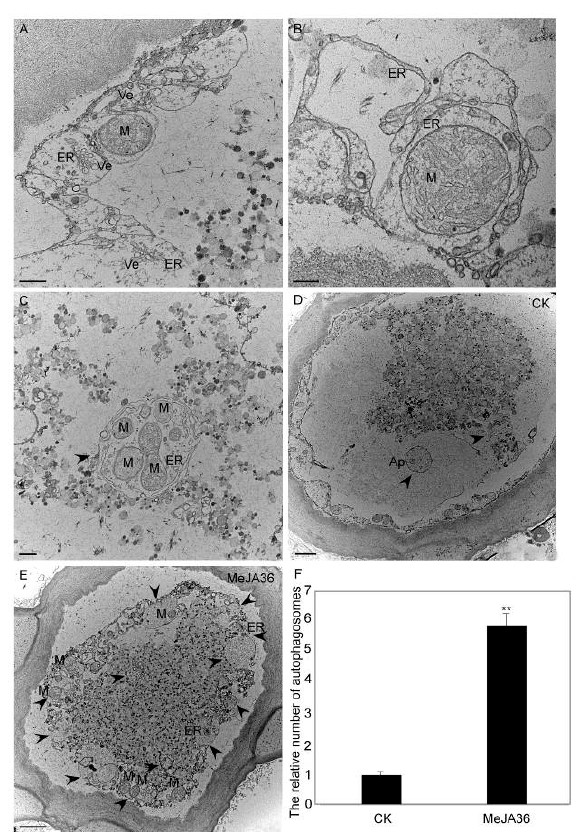
Figure 9. TEM analysis of the autophagy activation in laticifers of Euphorbia kansui treated with MeJA. ( A ) The early stages of autophagy in laticifers of E. kansui . ( B ) Autophagosomes are in the formative stage. ( C ) Representative TEM images of autophagy structures. ( D ) Laticifer TEM images of control groups of E. kansui . ( E ) Laticifer TEM images of E. kansui treated with MeJA. Arrows in ( B – E ) indicate autophagy structures. ( F ) Quantification of autophagy structures observed in laticifers of control groups and MeJA treated groups of E. kansui . Bar = 0.5 µ m for ( A , C ), bar = 0.2 µ m for ( B ), Bar = 2 µ m for ( D , E ). Mean and standard error (SE) were calculated from 10 visual fields at the same magnification. “**” indicate statistically significant ( p -value ≤ 0.01 versus control groups), measured by the Student t